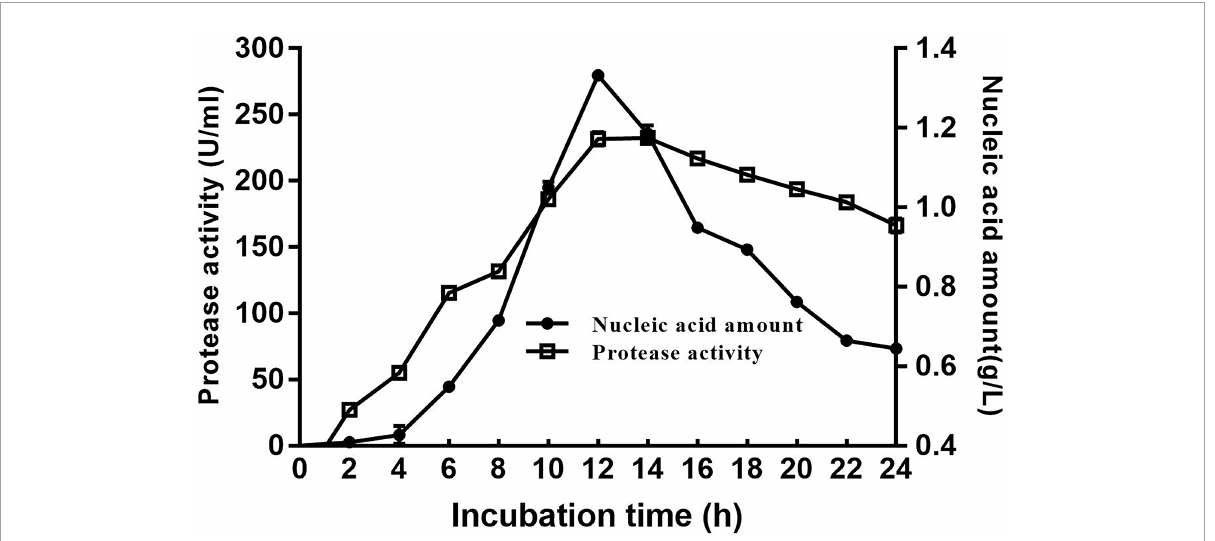
TABLE 2 Flow sheet for prot DS5 purification from Bacillus halotolerans DS5.